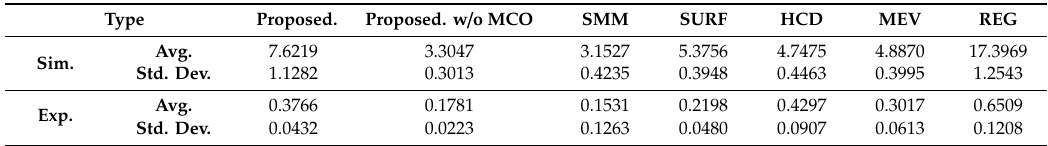
Table 3. Comparison of the averages and standard deviations of the computational times with di ff erent methods in simulations and experimental data (unit: